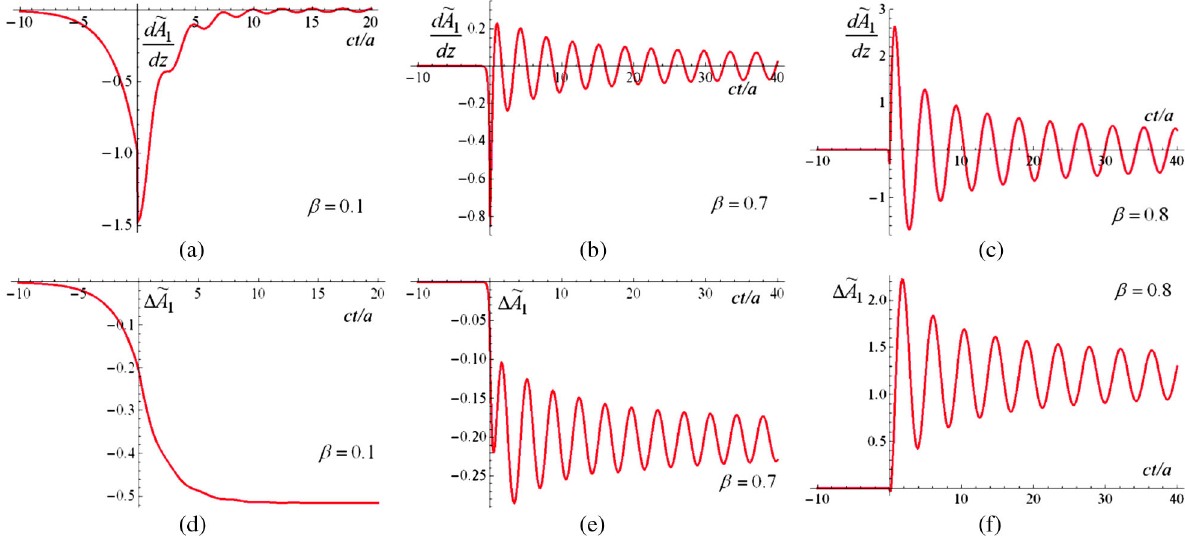
¼ 0 : 816 , and C 1